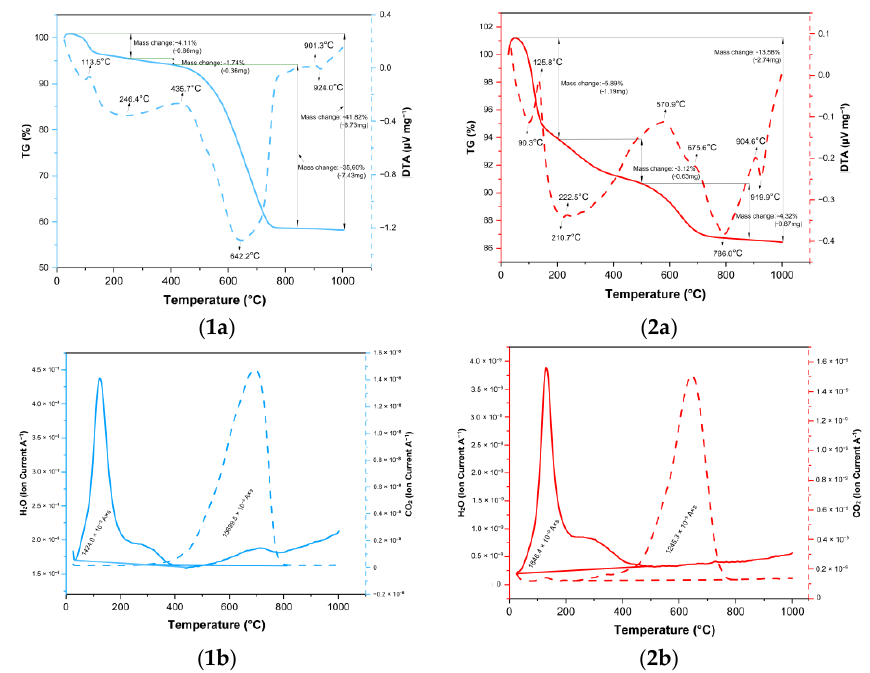
Figure 2. Thermal curves of ( 1 ) NaP1_C and ( 2 ) NaP1_FA [( a ) TG/DTA, ( b ) QMS].